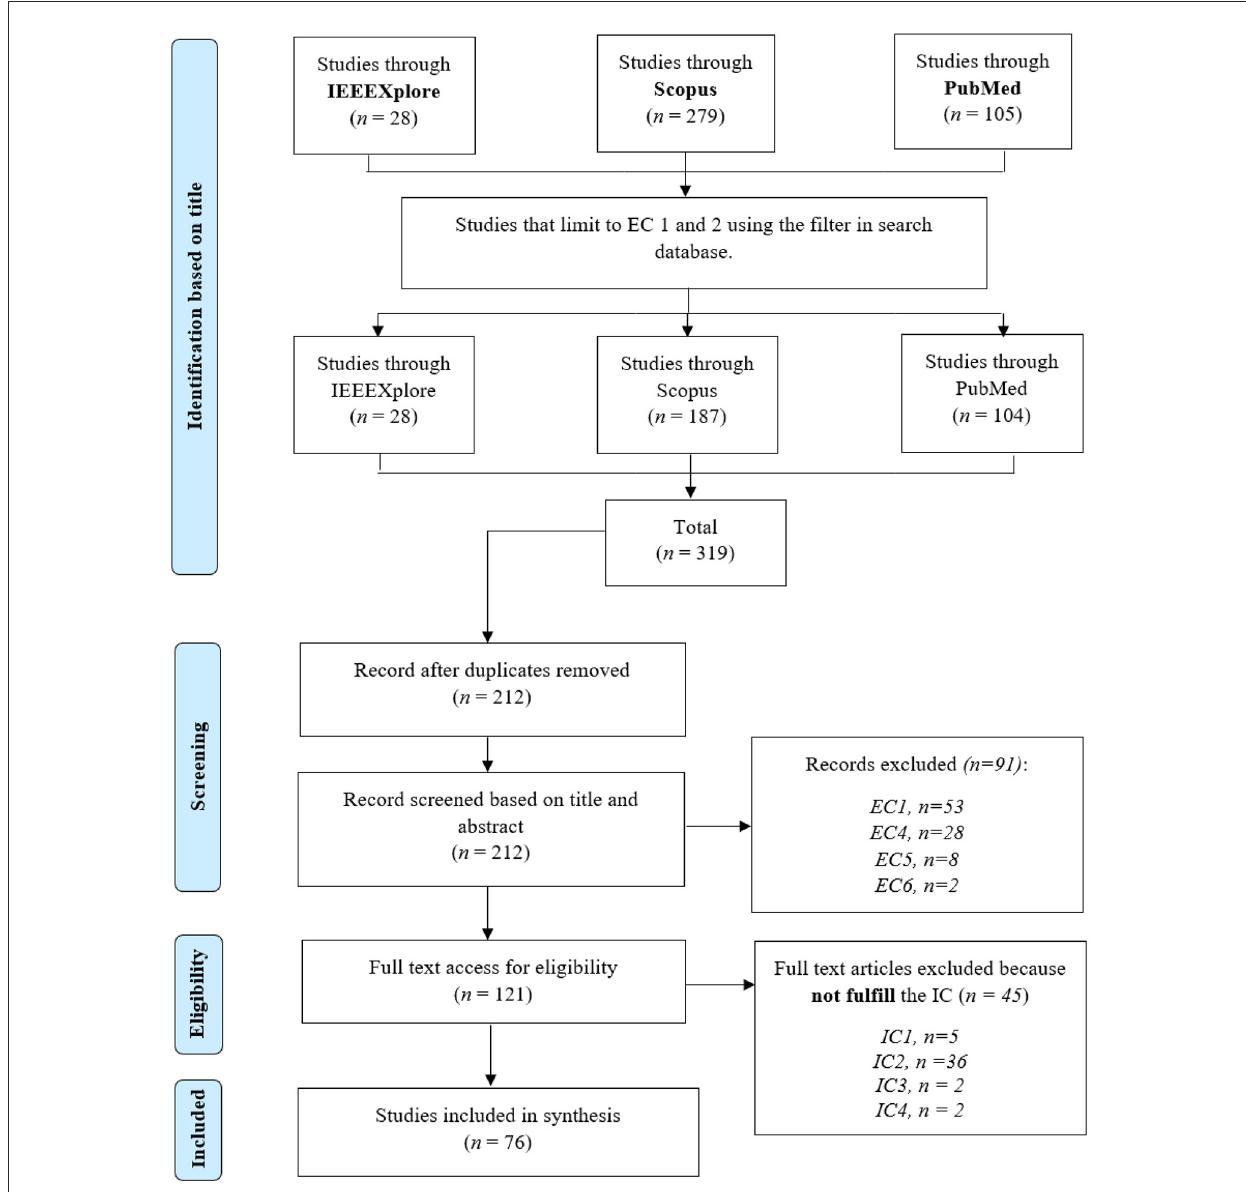
FIGURE3 The PRISMA flowchart. EC, exclusion criteria; IC, inclusion criteria; n , number of